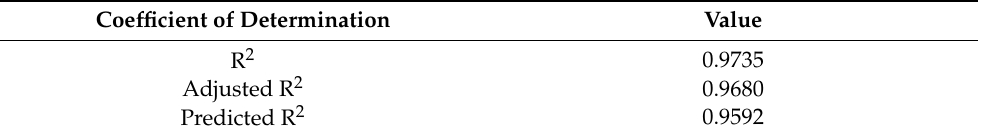
Table 10. Coefficient of determination for HC.